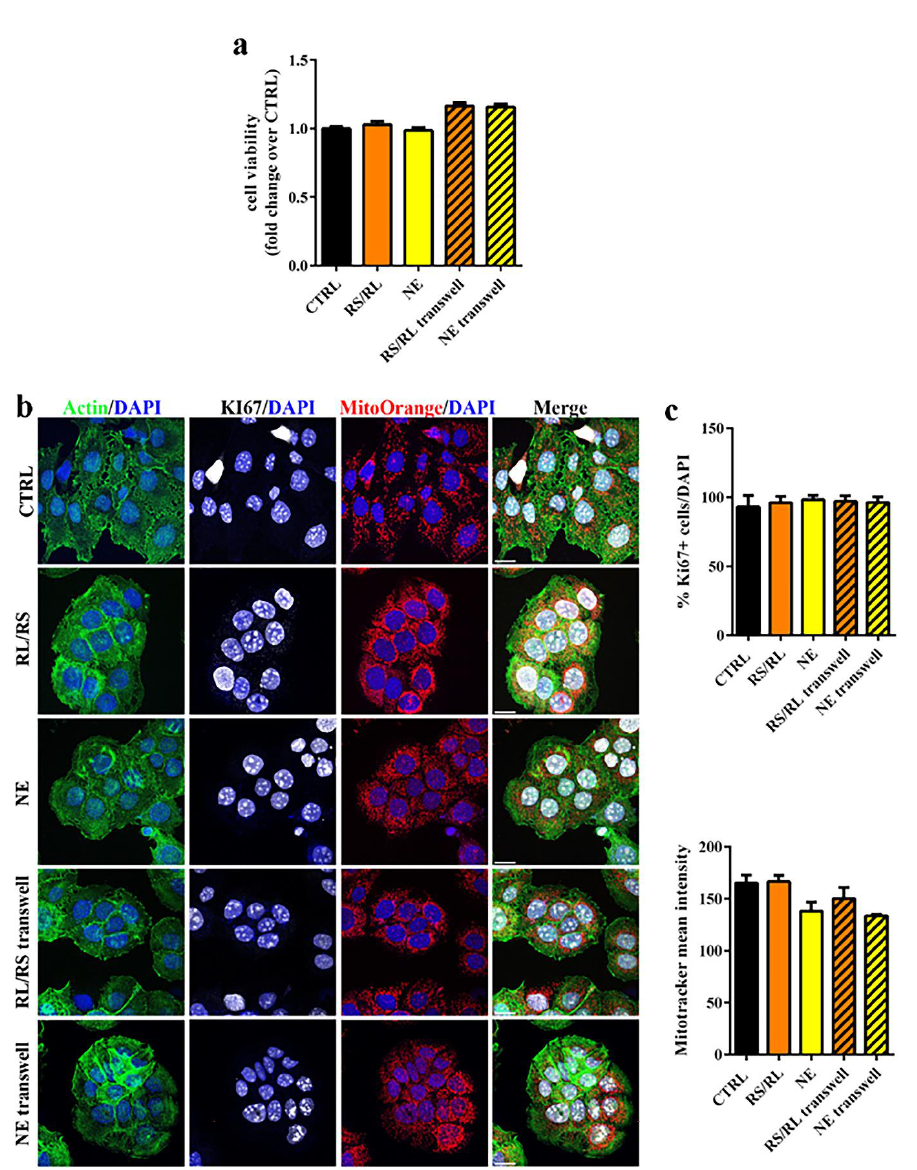
Figure 5. Cytotoxicity evaluation of Eudragit ® RS/RL- and Eudragit ® NE-coated specimens at 48 h of incubation. ( a ) Cell viability of HT1376 cells exposed to different samples for 48 h ( n = 6). Untreated cells (CTRL) were used as negative; ( b ) confocal microscope images of HT1376 cells stained with phalloidin to detect actin (green), Ki67 (white), Mitotracker Orange (red) and DAPI (blue) (20 µm scale bar); ( c ) upper panel: graph of the % of Ki67+ cells over total cells counted by DAPI staining; bottom panel: graph of the mean fluorescent intensity of Mitotracker Orange ( n = 3).